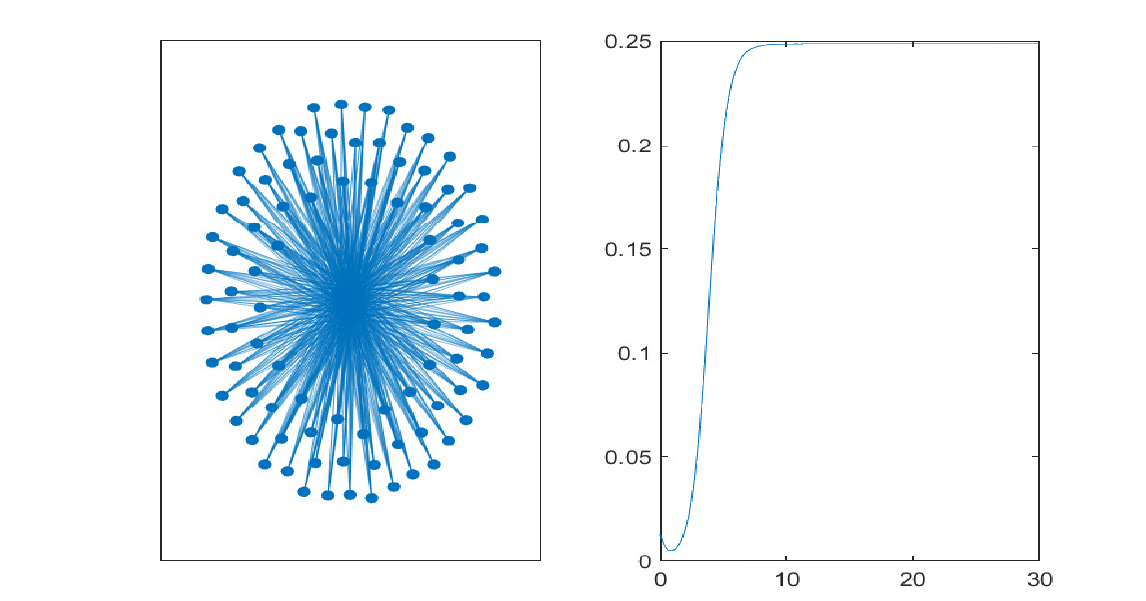
Figure 8. Core-periphery graph with 10 core nodes and 90 periphery nodes ( left ). Time evolution of the mean value of non-performing loans on the graph ( right